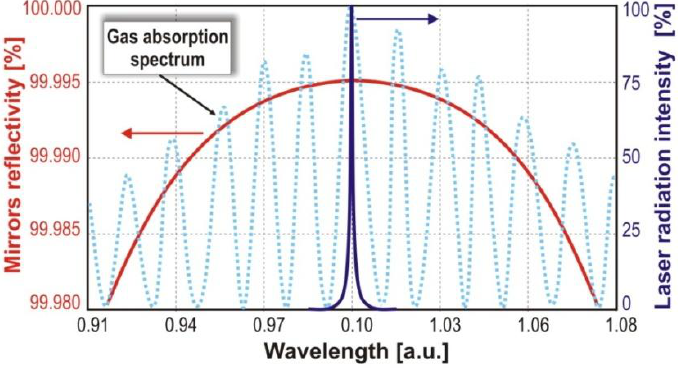
Figure 6. Illustration of matching the laser emission wavelength and cavity mirrors